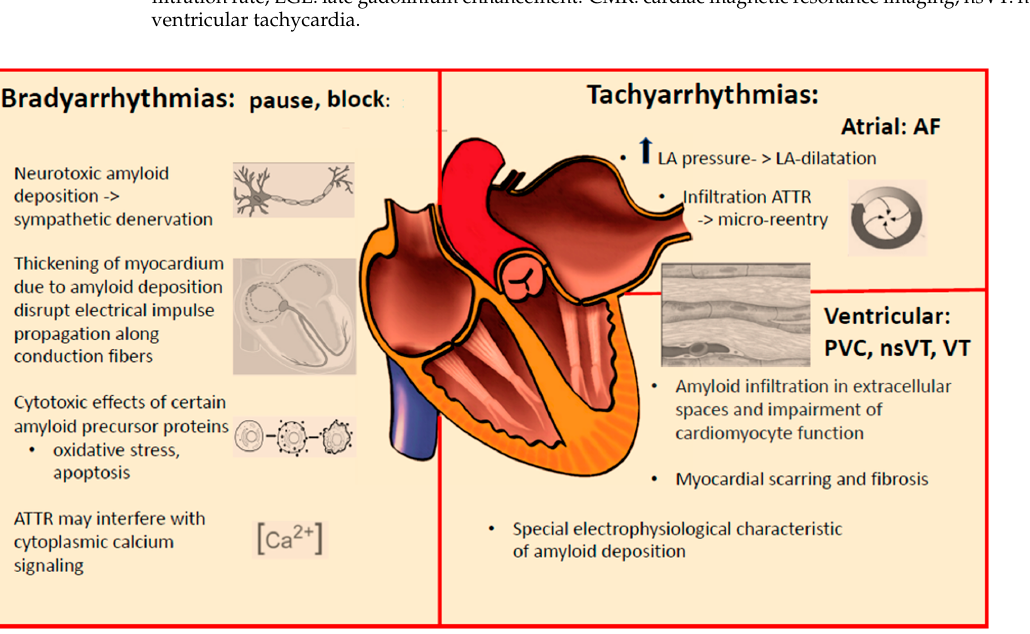
Figure 1. Main pathophysiologic factors causing arrhythmias in cardiac amyloidosis.LA: left atrium; AF: atrial fibrilation; PVC: premature ventricular contraction; nsVT: nonnonsustained ventricular tachycardia; VT: ventricular tachycardia; arrow means elevated. Table 3. Prognostic factors in the development of clinically relevant brady- and tachyarrhythmias in cardiac amyloidosis.